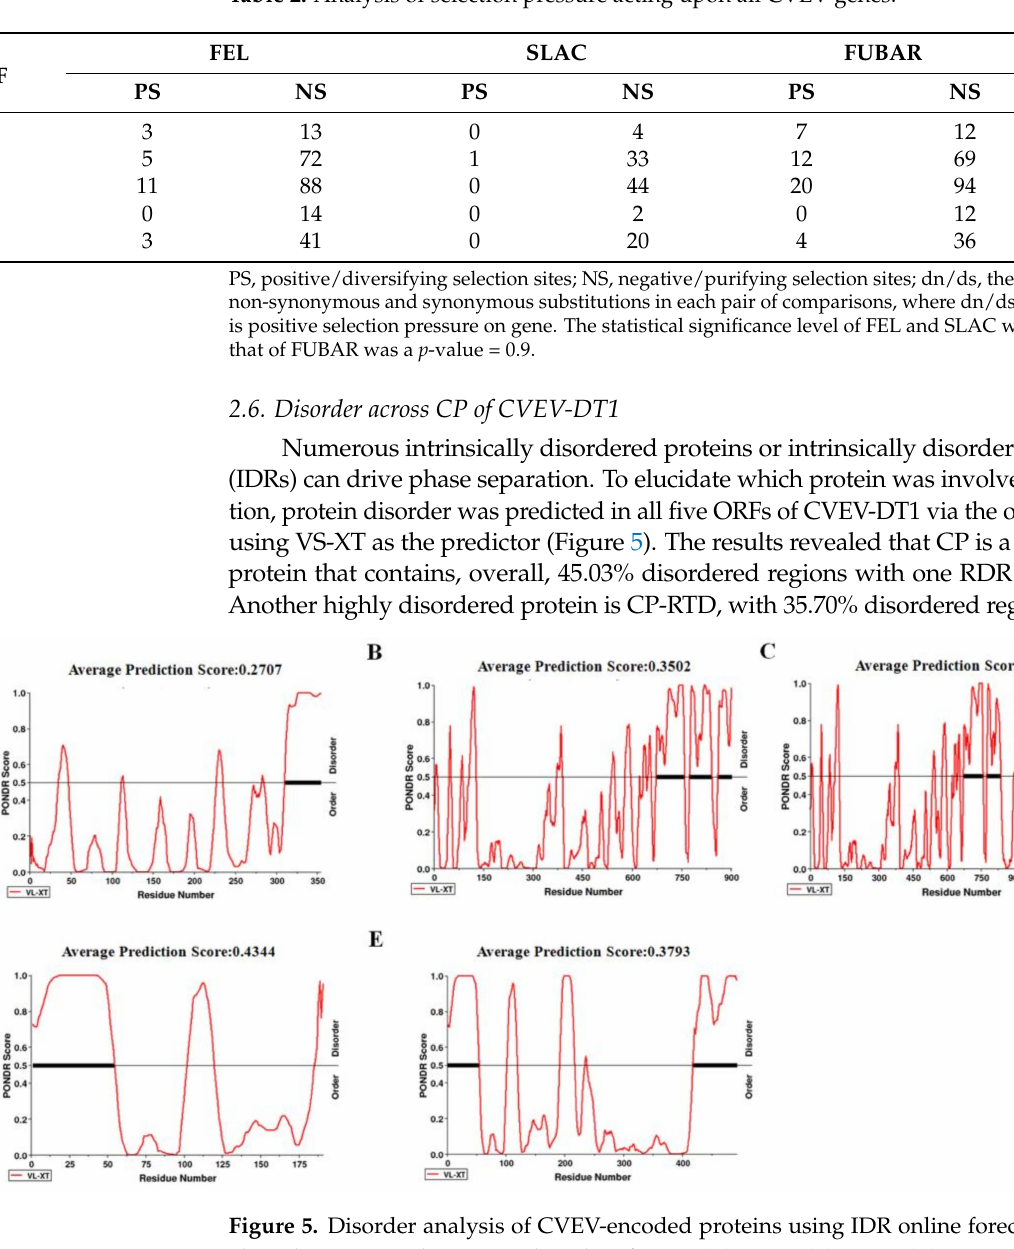
Table 2. Analysis of selection pressure acting upon all CVEV genes.